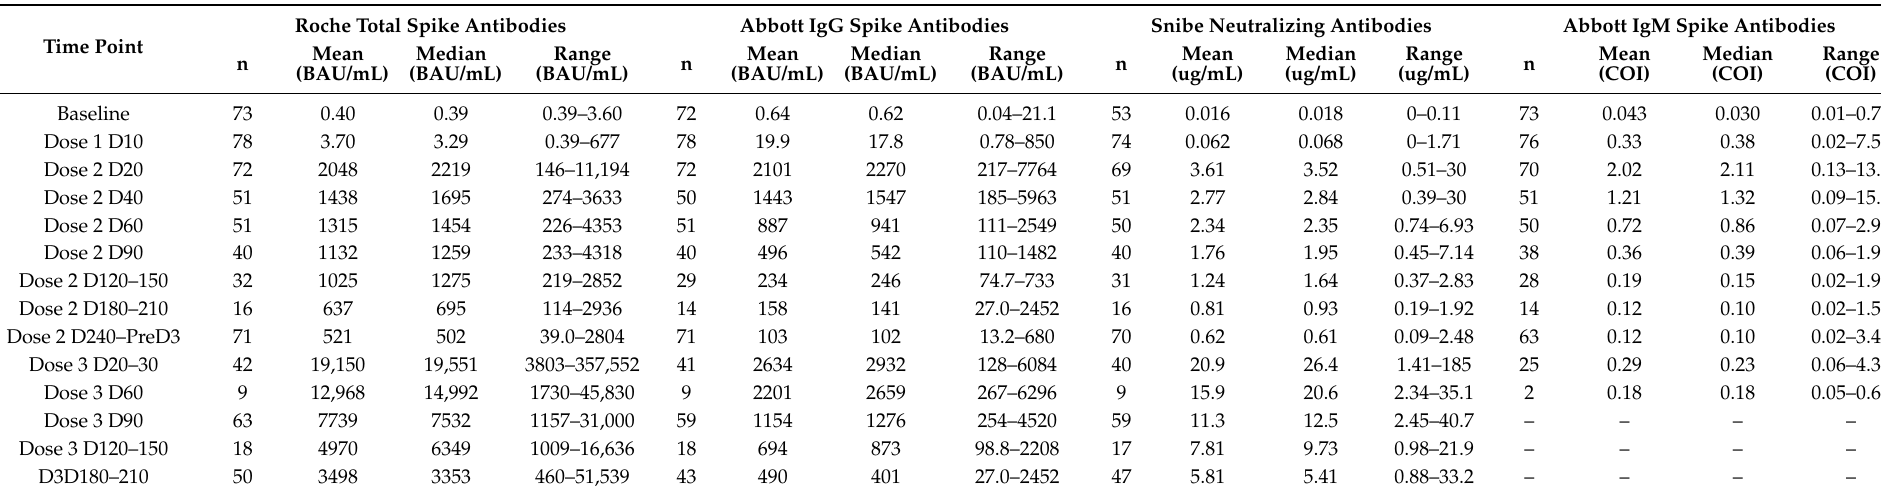
Table 1. Mean, Median and range of total spike, IgG spike, neutralizing and IgM spike antibody responses to 3 doses of Pfizer